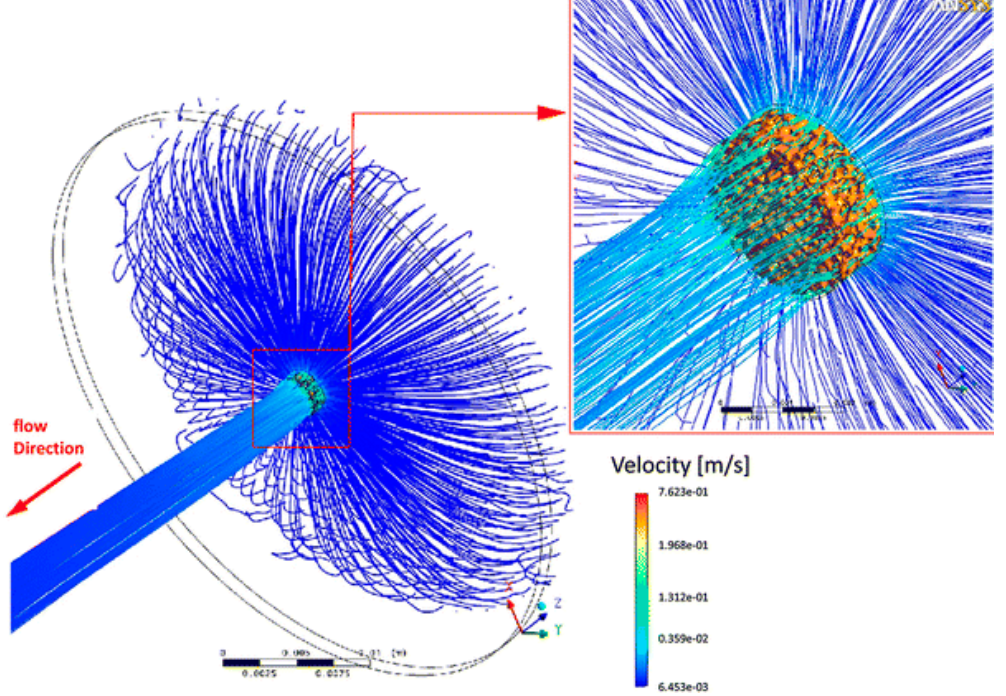
Figure 3. Fluid velocity streamlines along poly(L-lactic acid) non regular scaffold computed by means of computational fluid dynamics (CFD) analysis. Reprinted with permission from [84].